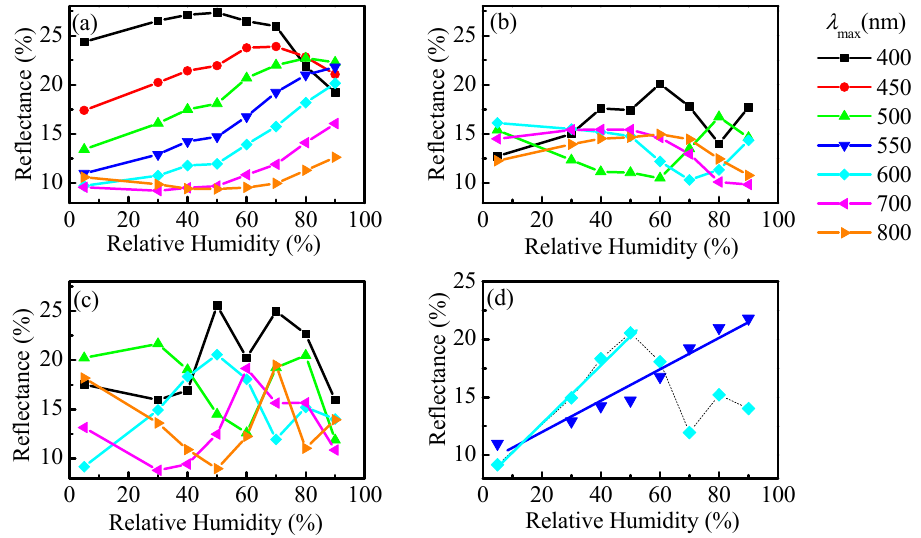
Figure 6. Reflectance at different wavelengths λ max measured as a function of relative humidity for films with initial thicknesses of 100 nm ( a ), 200 nm ( b ), and 300 nm ( c ) deposited on silicon substrates. The best results were obtained for thin film with an initial thickness of 100 nm (blue triangles) and 300 nm (cyan diamonds) ( d ).